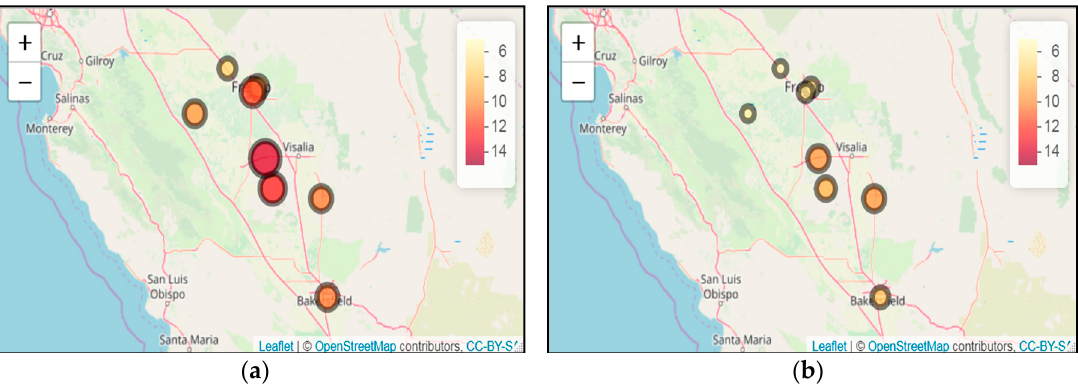
Figure 6. Spatial distribution of DRAGON AERONET—PM 2.5 calibration model error (RMSE) from the ( a ) baseline model; and ( b ) Model 3.